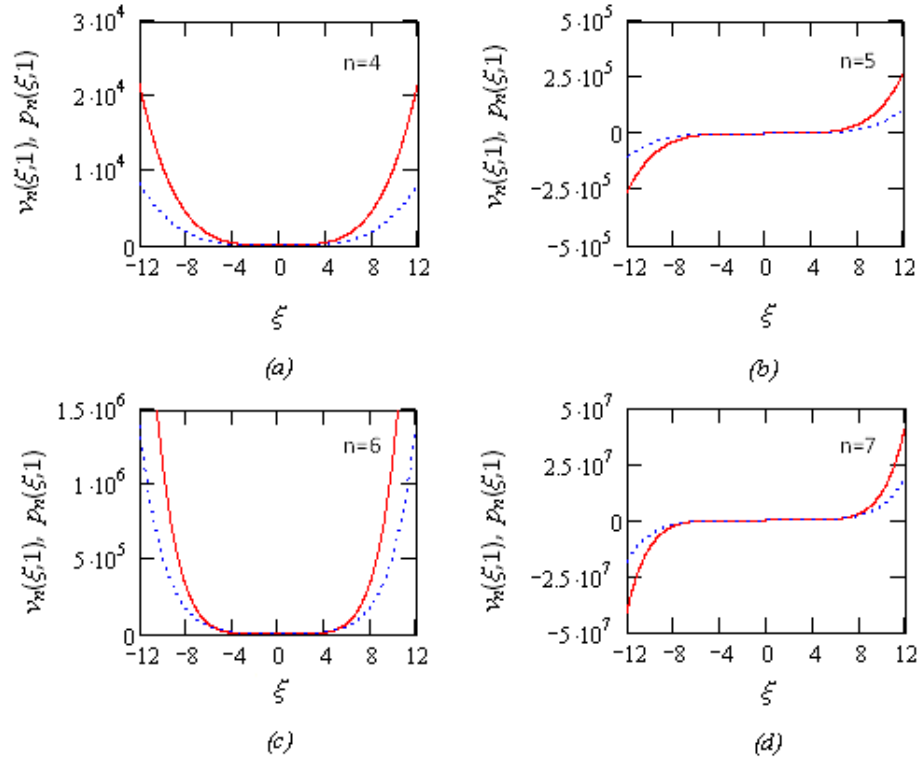
Figure 8. Plots of the p at ζ = 1